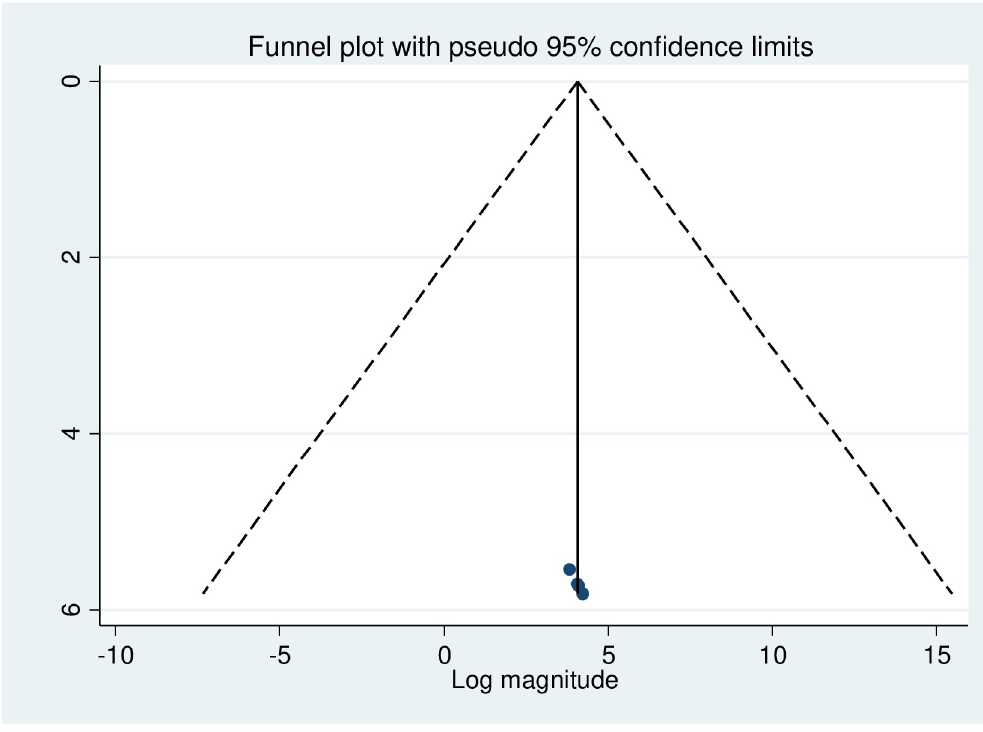
Fig 3. Funnel plot for detecting publication bias on eHealth literacy in Ethiopia